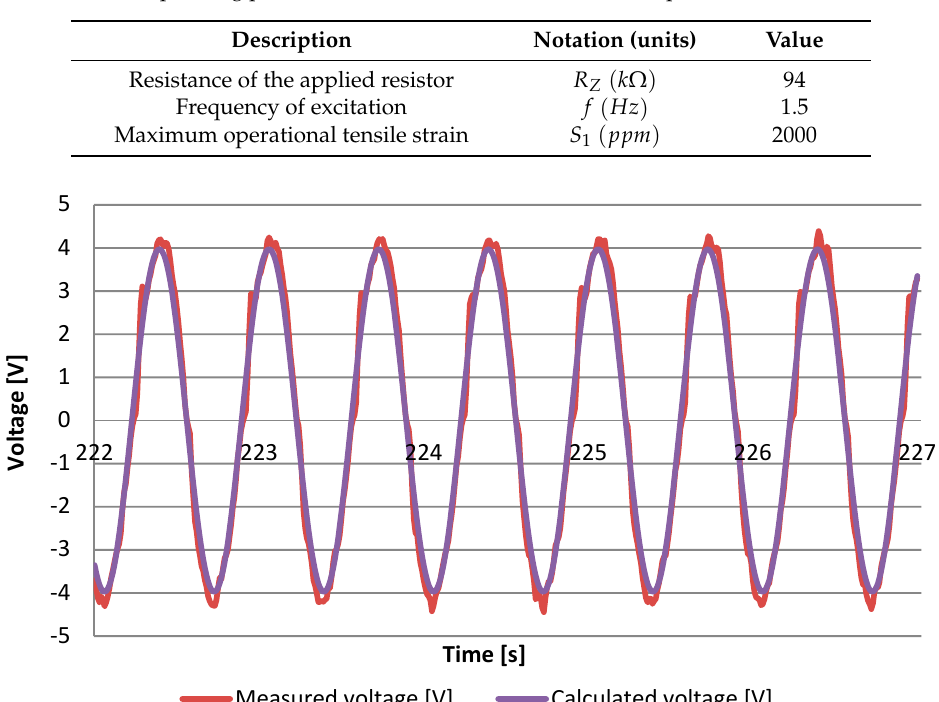
Table 2. The operating parameters of the tested Macro Fibre Composites (MFC) transducer.